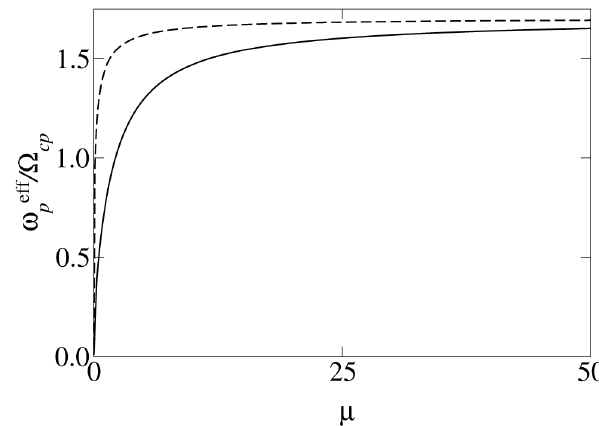
Fig. 6. Solutions of the dispersion relation Eq. (40) for α = 0 . 1 and v A 0 = 1. Solid line µ = 700 ( f ’ 1); dashed line µ = 50 ( f ’ 1 . 1); dotted line µ = 3 ( f ’ 2); dot dashed line µ = 0 . 4 ( f ’ 10). At the scale of the figure, the dashed and solid lines for the electromagnetic branch cannot be distinguished. Also, the dotted and dot dashed lines for the Alfvén branch cannot be seen; this occurs because, for high temperatures, the Alfvén branch disappears, as discussed later in Fig. 8.